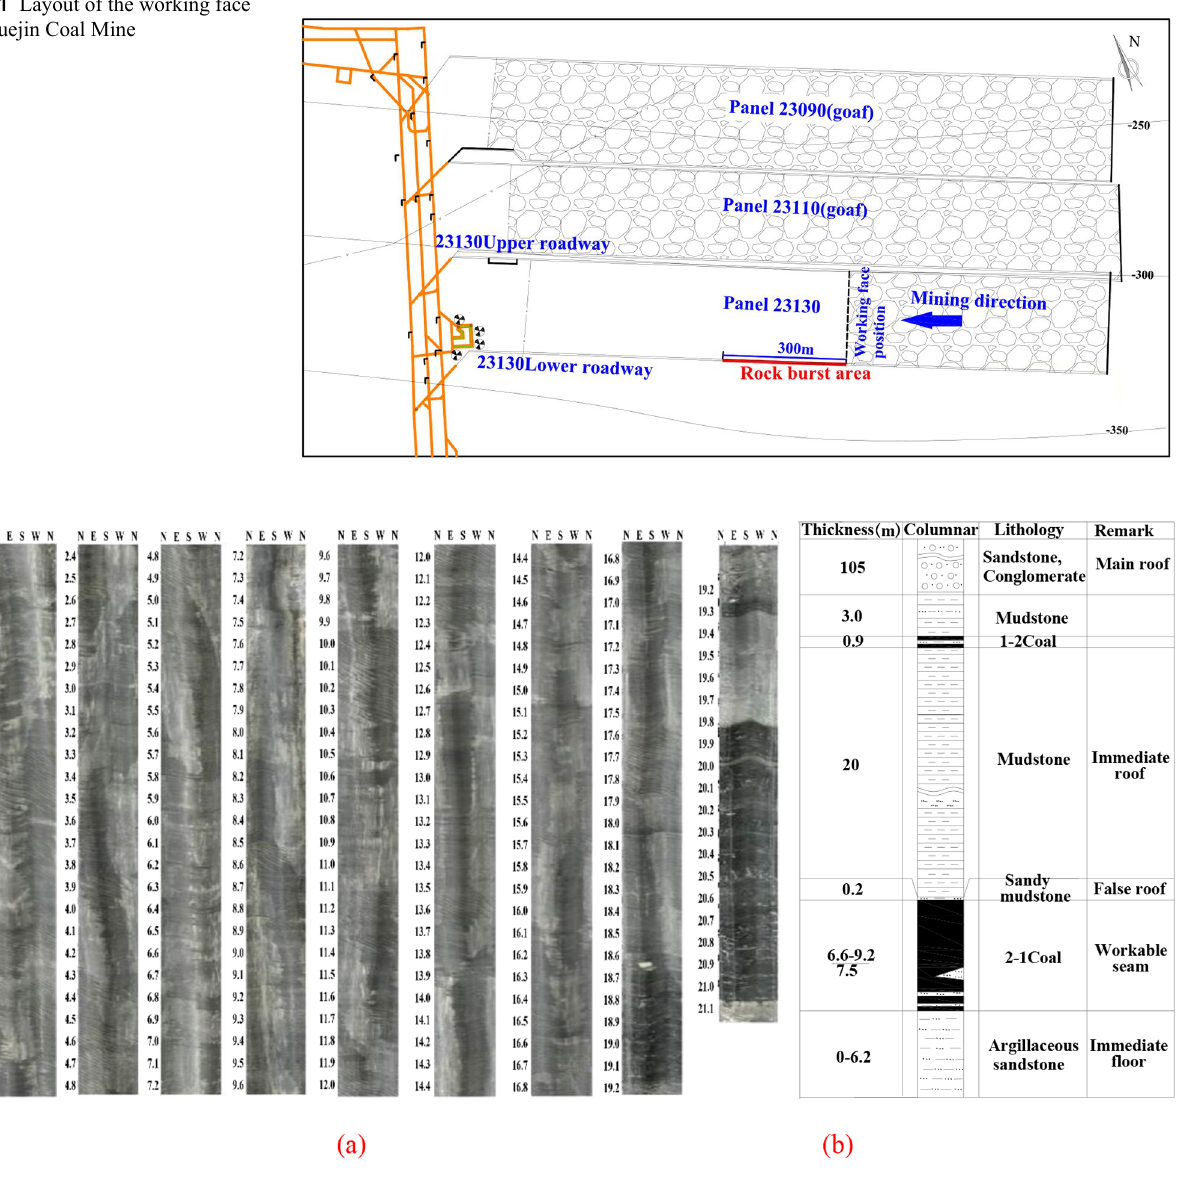
Fig. 2 The observation results of the belt transport roadways at 23130 working face